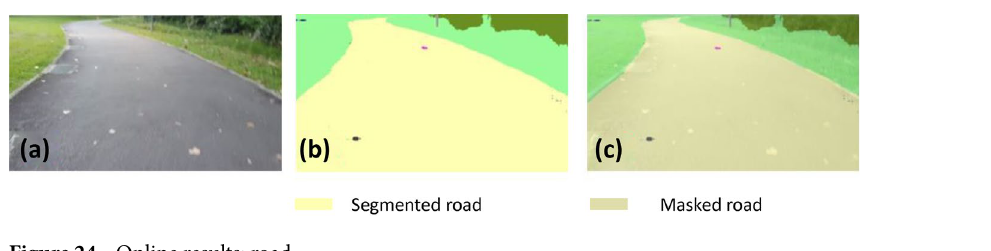
Figure 24. Online results: